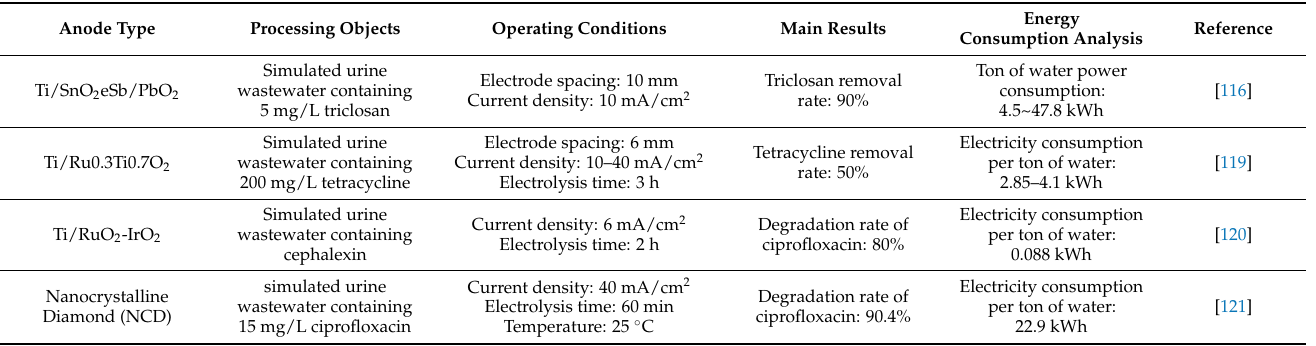
Table 5. Electrochemical treatment of urine wastewater containing pharmaceutical